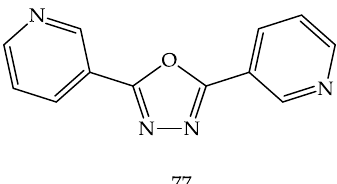
Figure 22. Thymidine phosphorylase enzyme .